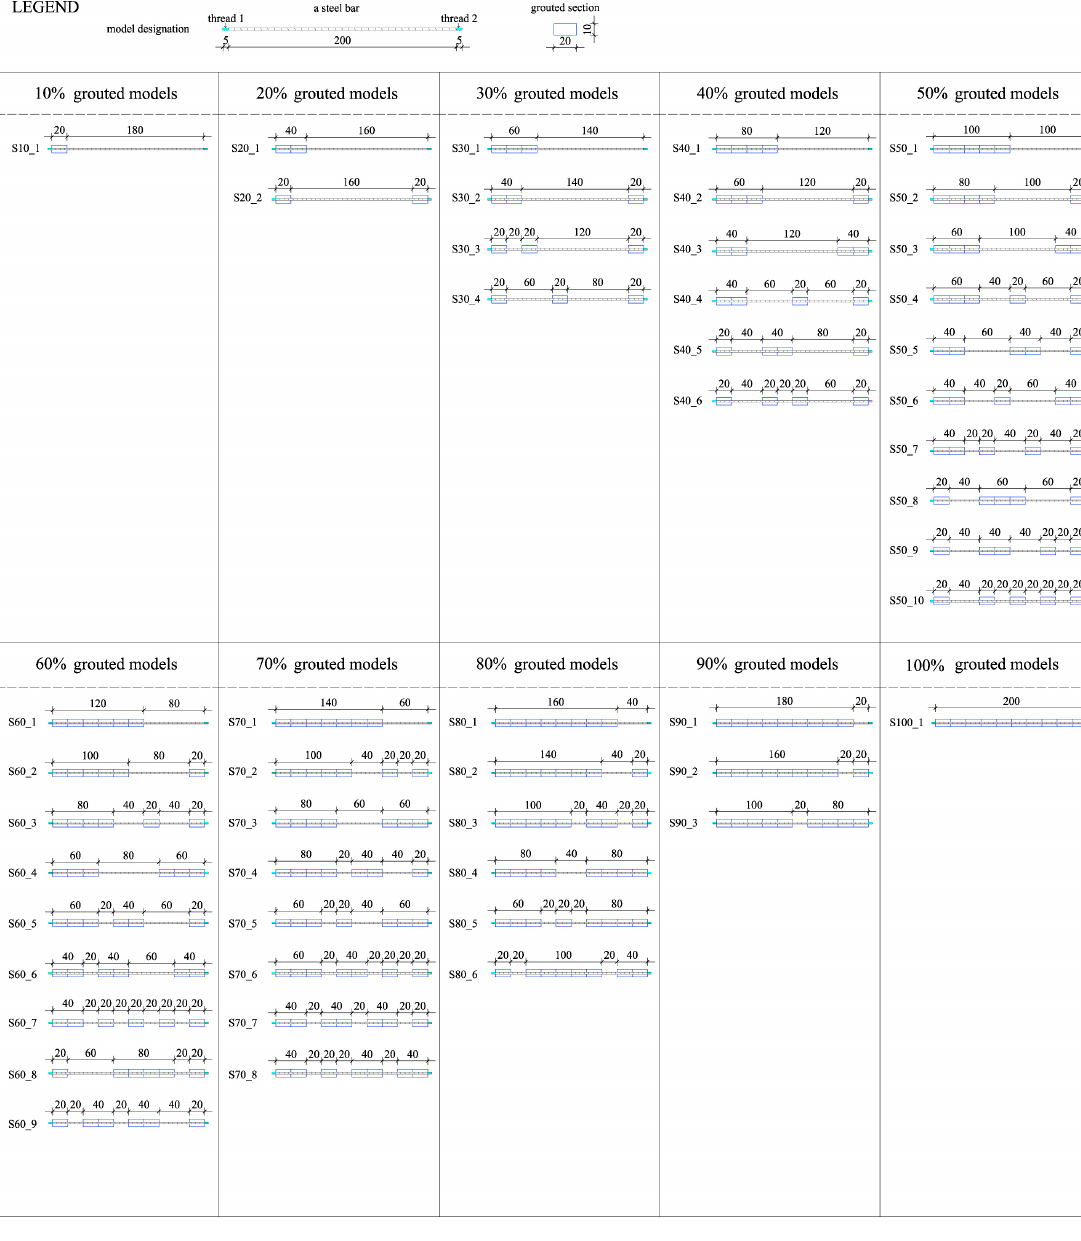
Figure 4. Complete scheme of rock bolt laboratory models.